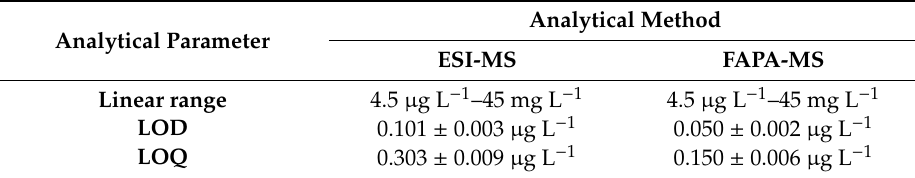
Figure 9. Dependence of signal intensity vs. amygdalin concentration in the sample. Table 3. Summary of analytical parameters.